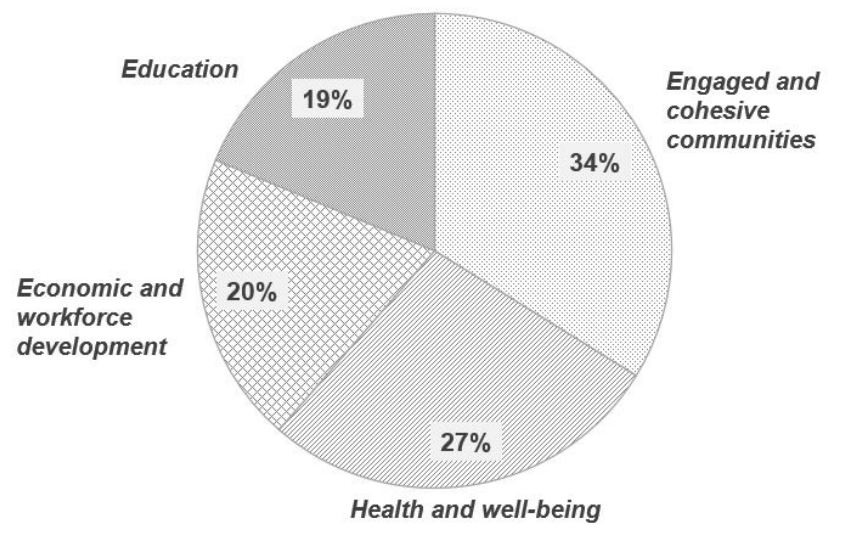
Figure 4. Studies by their primary thematic focus ( n = 272).